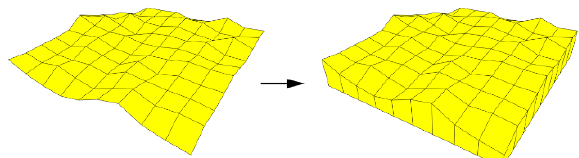
Figure 4. Adding a “skirt” around the tile efficiently hides cracks.